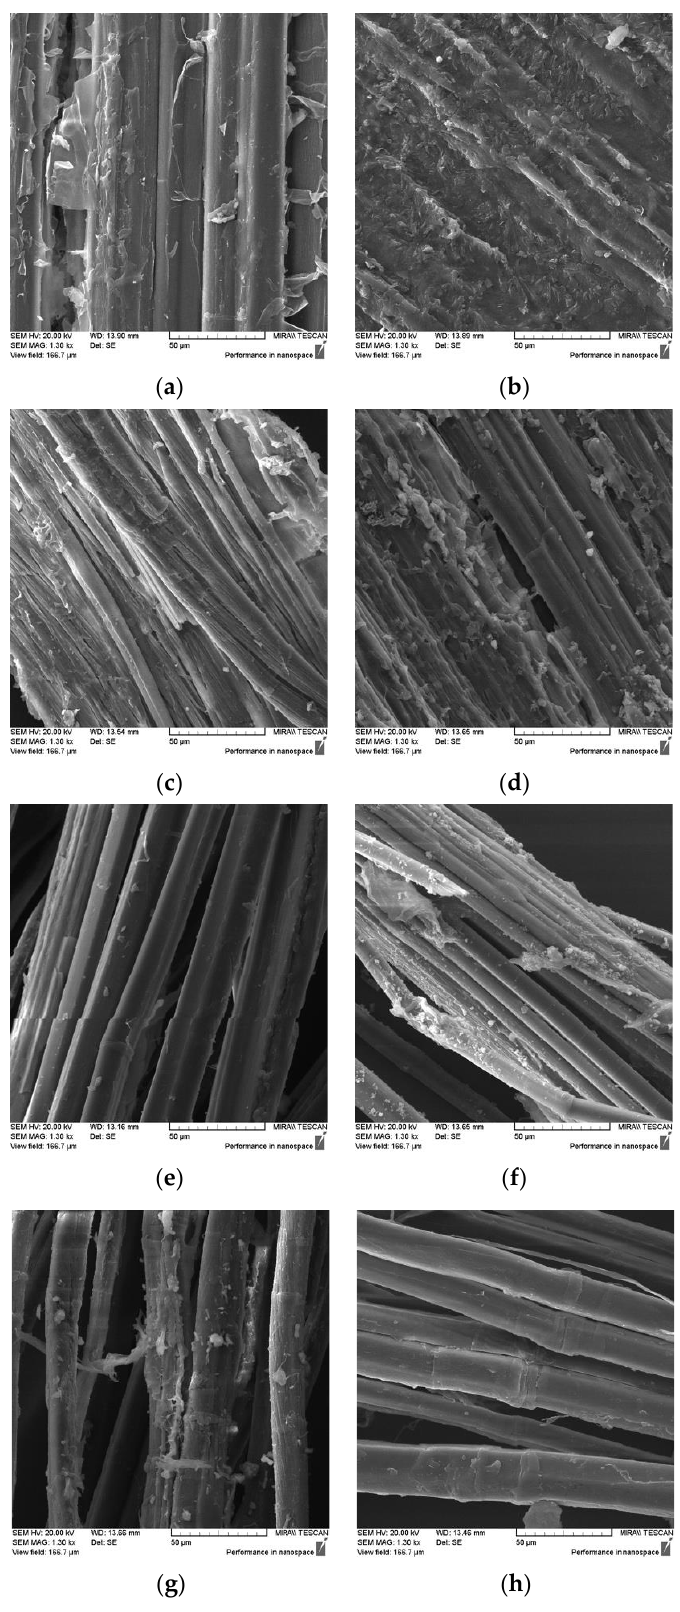
Figure 15. SEM images of untreated and treated flax and hemp fibres before and after the degrada- tion test. ( a ) Natural and untreated flax fibres. ( b ) Flax-treated stearic acid 4 h. ( c ) untreated flax fibres degraded. ( d ) treated flax fibre degraded. ( e ) Natural and untreated hemp fibres. ( f ) Hemp fibres treated NaOH10% 24 h. ( g ) untreated hemp fibres degraded. ( h ) treated hemp fibre degraded.